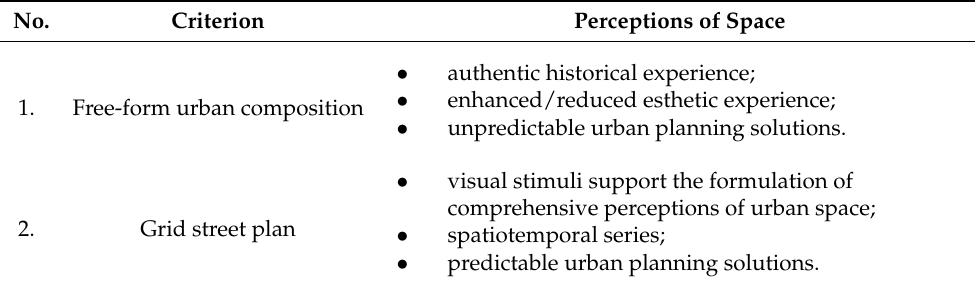
Table 4. The influence of urban design on perceptions of